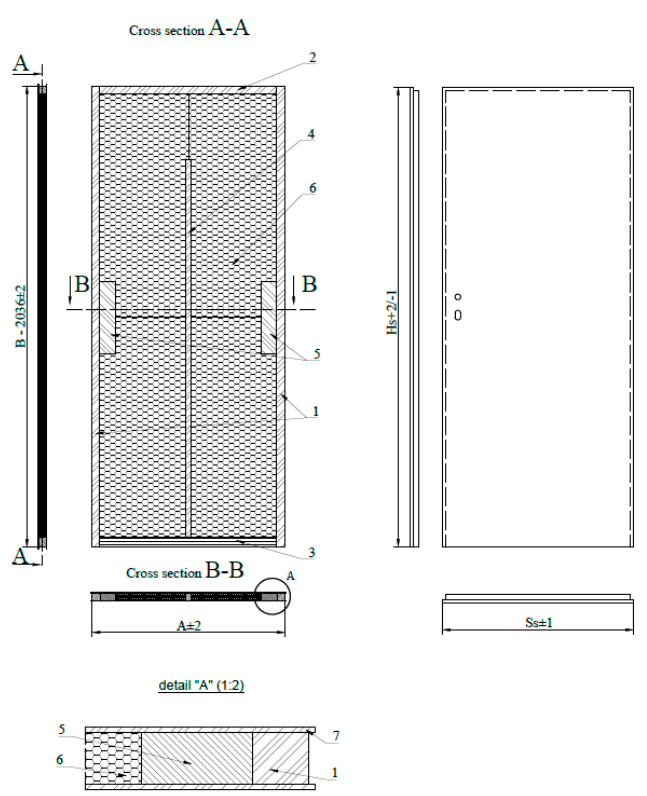
Figure 5. Door construction 3.